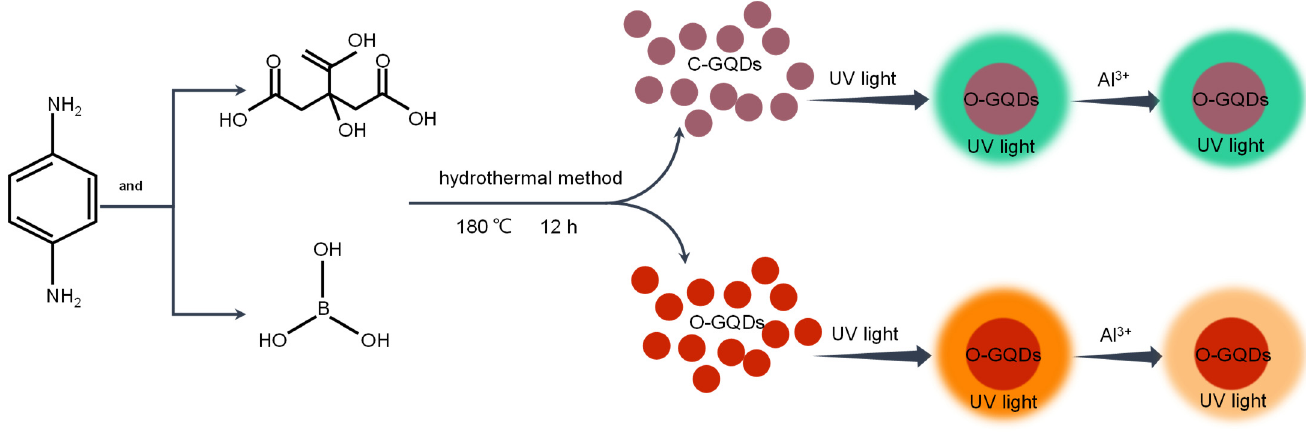
Figure 1. Preparation flow chart of c-GQDs and o-GQDs.